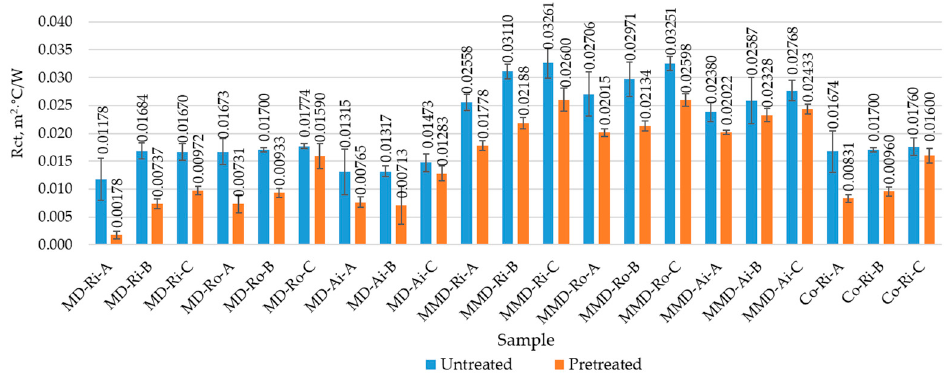
Figure 16. Thermal resistance (Rct) of the untreated and pretreated socks determined before and after five repeated washing and drying cycles (where MD—modal fibers, MMD—micro modal fibers, CO—cotton fibers; Ri—ring spun yarn, Ro—rotor spun yarn, Ai—air-jet spun yarn; A, B, C—sock group). Table 9. Mean values of the comfort properties calculated for groups A, B and C of the untreated and pretreated socks made from differently spun modal and micro modal yarns.